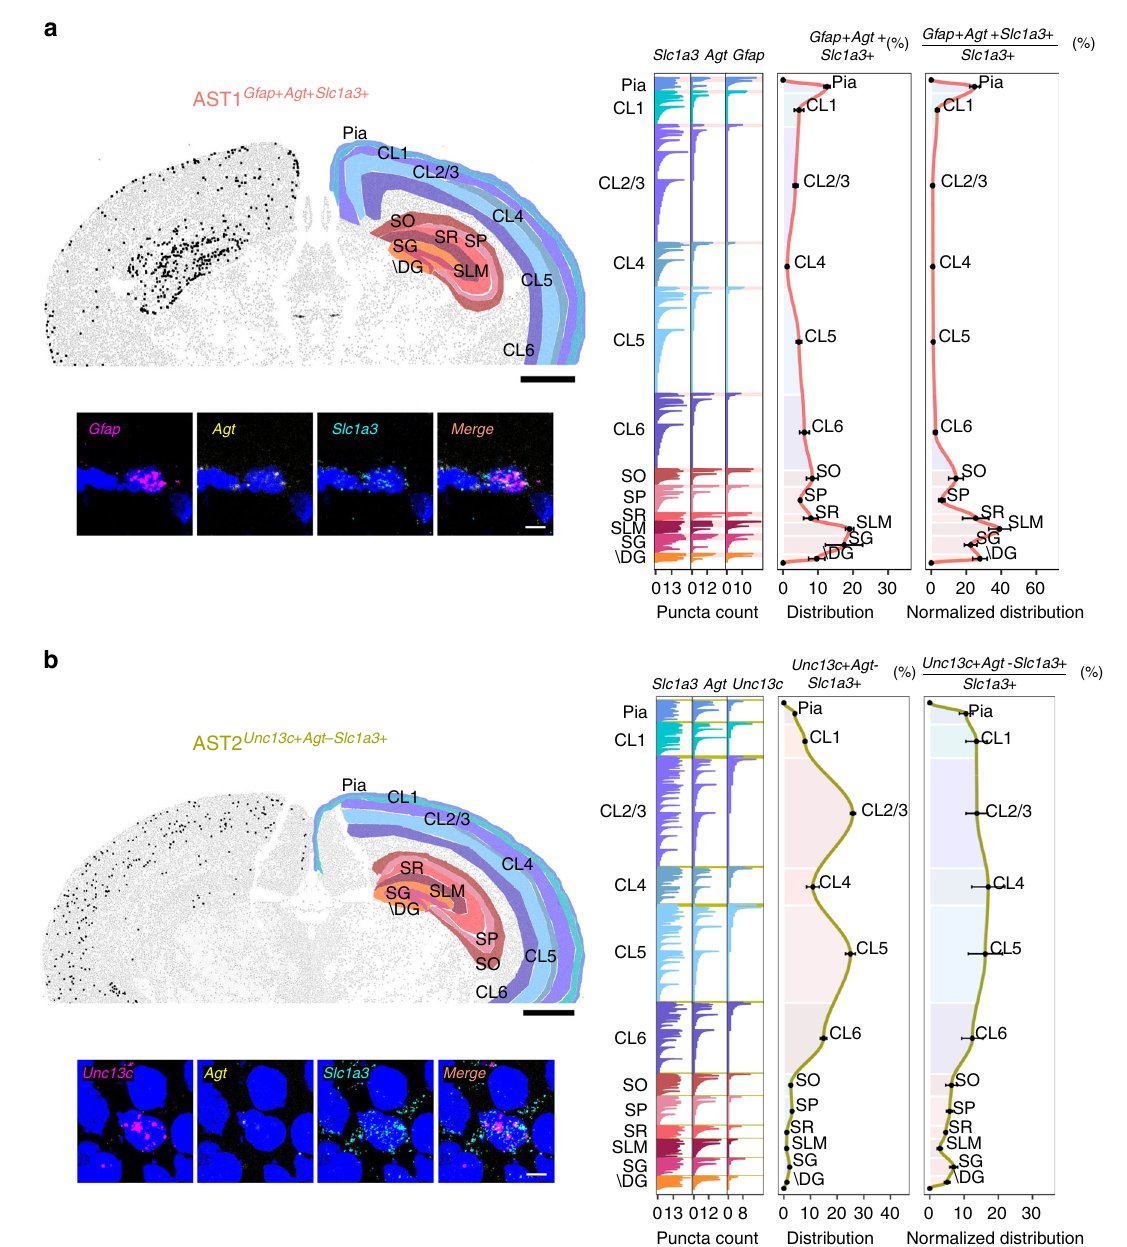
Fig. 5 Differential patterning of AST1 and AST2 in adult mouse brain. Multiplexed fl uorescence in situ hybridization was used to map locations of AST1 and AST2. a AST1 was identi fi ed by high expression levels of Gfap , Agt , and Slc1a3 . b AST2 was identi fi ed by low expression/absence of Agt and high expression of both Unc13c and Slc1a3 . Mapping was performed on three sections obtained from three independent animals aged between P56 and P60. Representative images are shown. Top left: low-magni fi cation image of a coronal section. Black dots show the distribution of the astrocyte subtype through one brain hemisphere. Brain regions are de fi ned manually based on de fi nitions from the Allen Brain Atlas. High-magni fi cation images (below) show the localization of markers to speci fi c cells de fi ned on the basis of nuclear (DAPI, blue) staining. Right: bar plots (showing from left to right) fl uorescence counts per RNA marker per cell (shown for all cells across all sections analyzed), the distribution of the subtype between brain regions, and the distribution of the subtype normalized to the total number of astrocytes per brain region (all Slc1a3 + cells). Astrocytes belonging to the subtype of interest are highlighted by a shaded box (color-coded according to the scheme used in Fig. 2a). Astrocyte numbers across layers are given as average per section analyzed. Error bars are equivalent across the fi gure and represent SEM. Scale bars, low magni fi cation 1000 µ m; high magni fi cation, 10 µ m. “ + ” high gene expression, “ − ” low or absent gene expression. SO Stratum oriens, SP Stratum pyramidale, SR Stratum radiatum, SG Subgranular zone, \DG Dentate gyrus without SG, SLM Stratum were plotted as fractional fl uorescence changes relative to baseline To eliminate potential bias, caused by manual assignment of (dF/F o ) (Fig. 8a). Although we observed signi fi cant differences in cells to brain regions, we performed unbiased hierarchical activity between astrocytes across regions in baseline and TTX clustering of astrocytes, based on the various Ca 2 + peak parameters recorded following PHE application (Fig. 8d, e). We conditions, the most striking differences were seen after appli- identi fi ed three distinct clusters of astrocytes, which were cation of PHE (Fig. 8c).